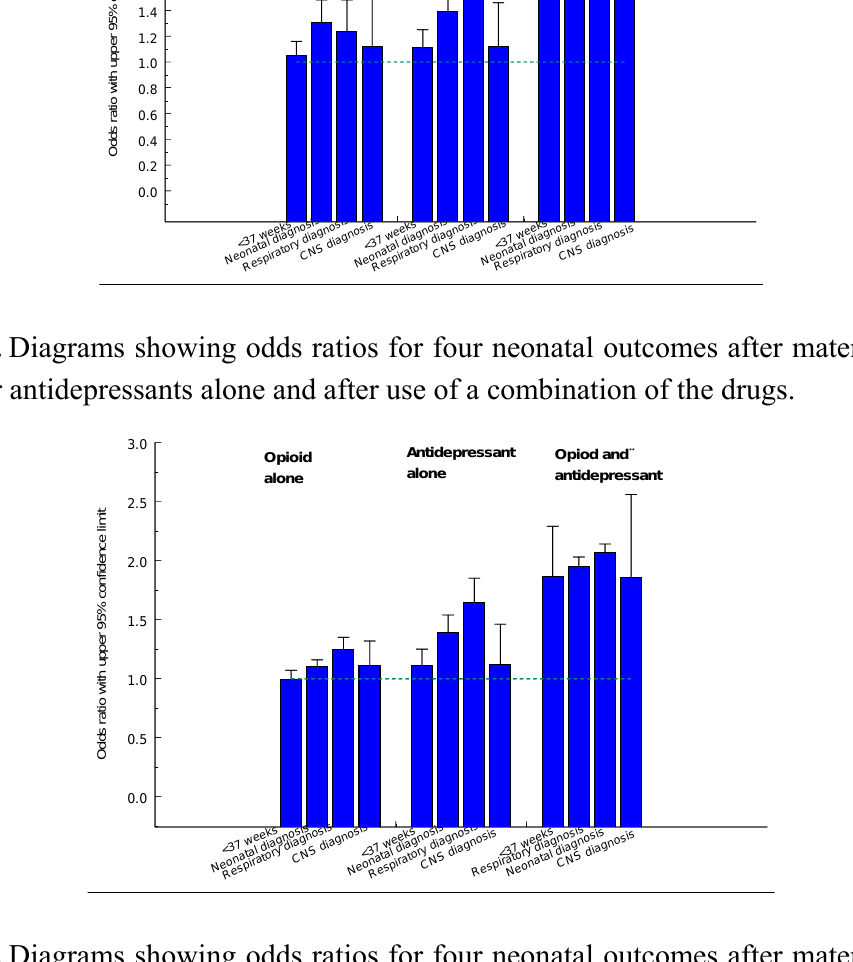
Figure 9. Diagrams showing odds ratios for four neonatal outcomes after maternal use of anticonvulsants or antidepressants alone and after use of a combination of the